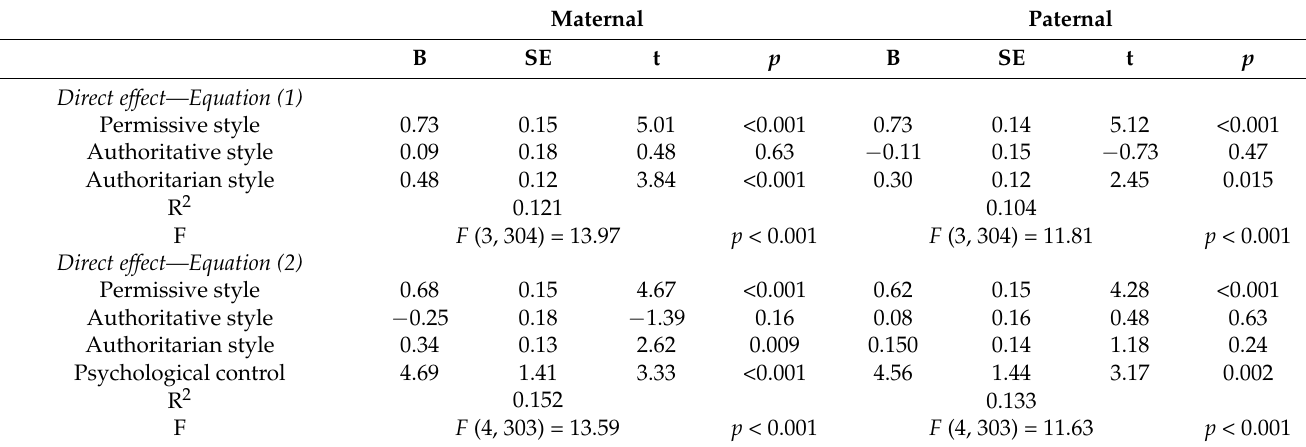
Table 2. Regression analysis predicting the child’s impostor feelings from the parental variables. Maternal Paternal B